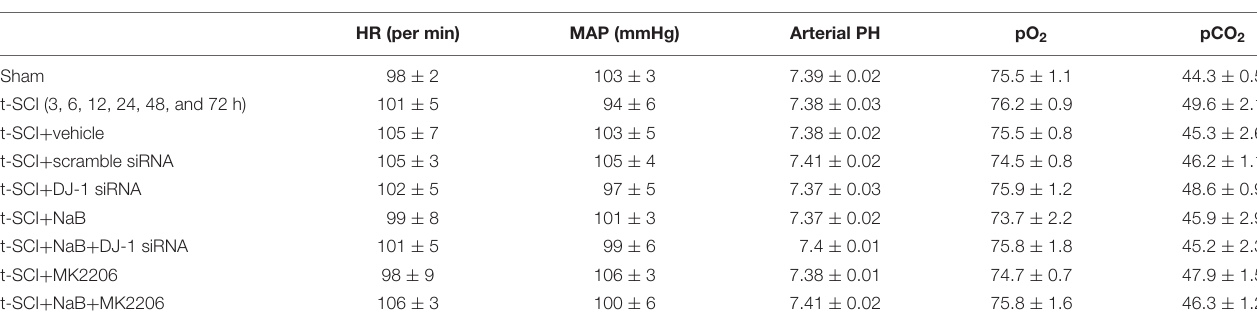
TABLE 2 | Main physiological data for rats in each group.